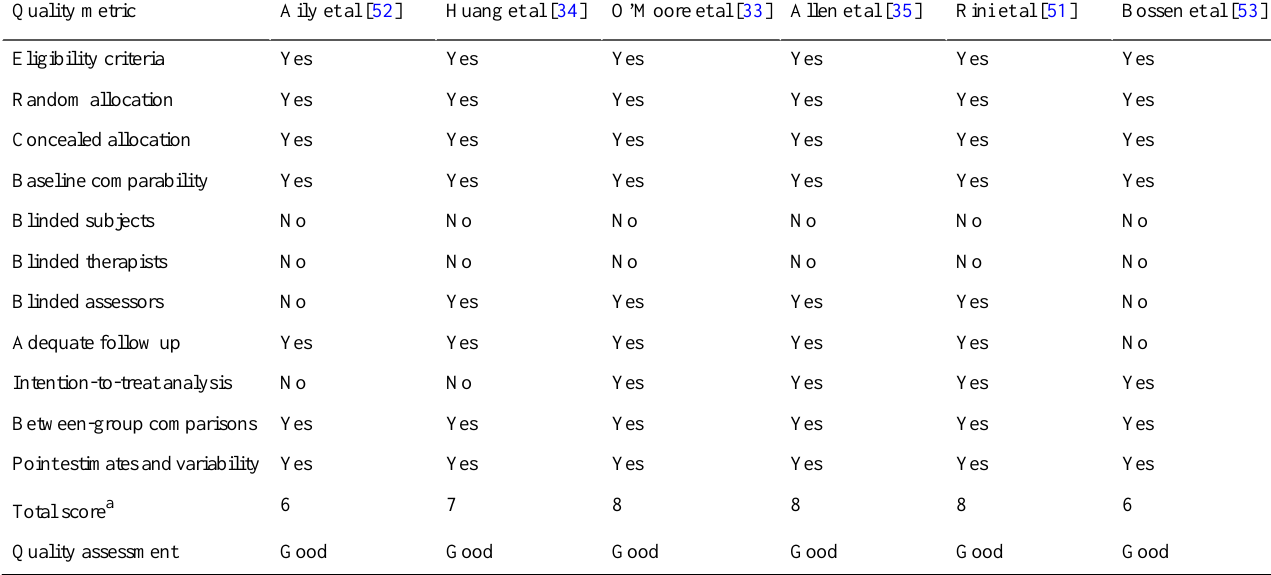
Table 2. Assessment of methodological quality using the PEDro